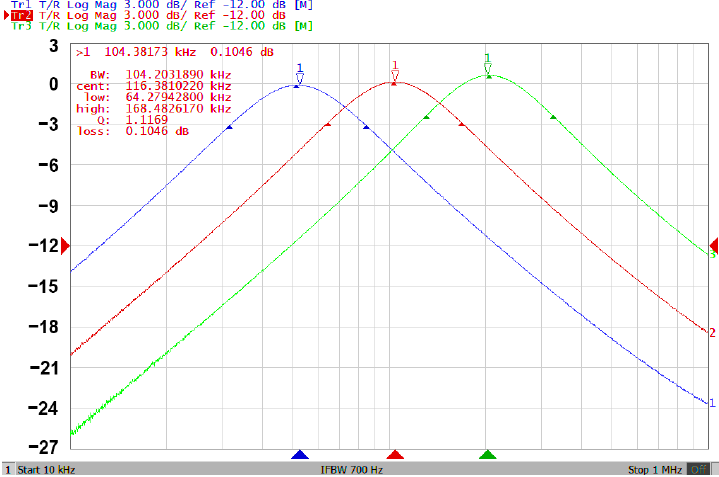
Figure 13. The experimental results of gain responses by varying f o while keeping Q (f o = 52.4 kHz—blue line; f o = 104.4 kHz—red line; and f o = 203.8 kHz—green line).